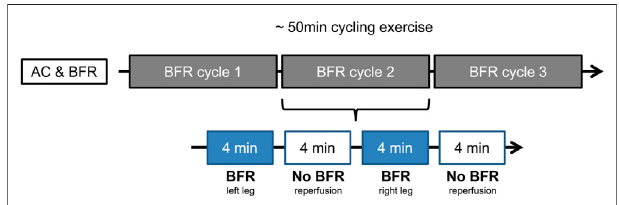
FIGURE 1 | Example of prehabilitation week four for AC- and BFR- group. The 50-min ergometer exercise is divided into three cycles. Each cycle consists of the application of the BFR stimulus to both legs in alternation, followed bya rest. Asshown here, theleft leg is loaded withBFR fi rst (for 4 minutes in week four), followed by a rest of 4 min. This is followed by BFR application to the right leg with a subsequent break. This cycle is repeated a total of three